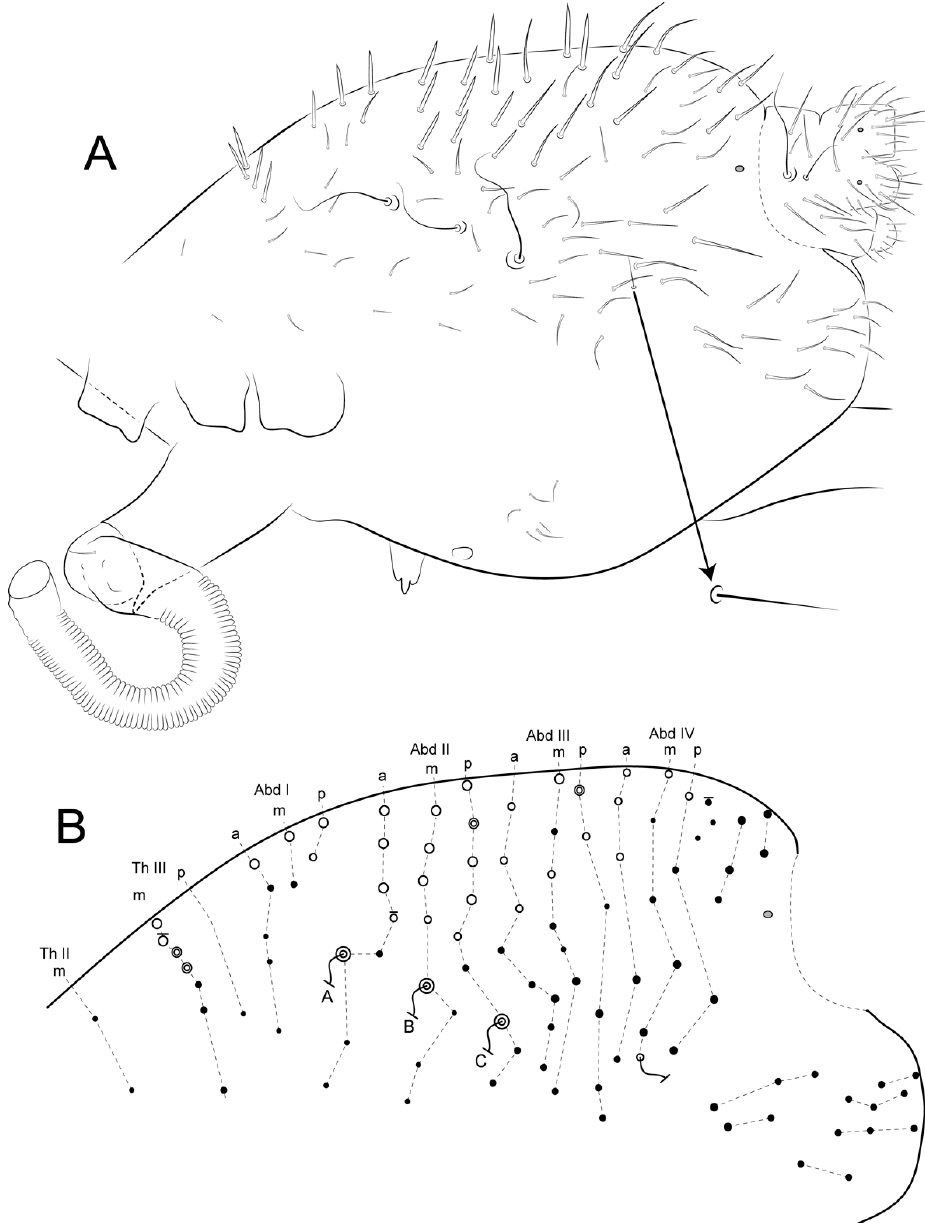
Figure 10. Arlesminthurus caatinguensis sp. nov. male, large and small abdomens (lateral view): ( A ) chaetotaxy as observed, arrow indicates extra bothriotrichum; ( B ) schematic representation of the large abdomen .